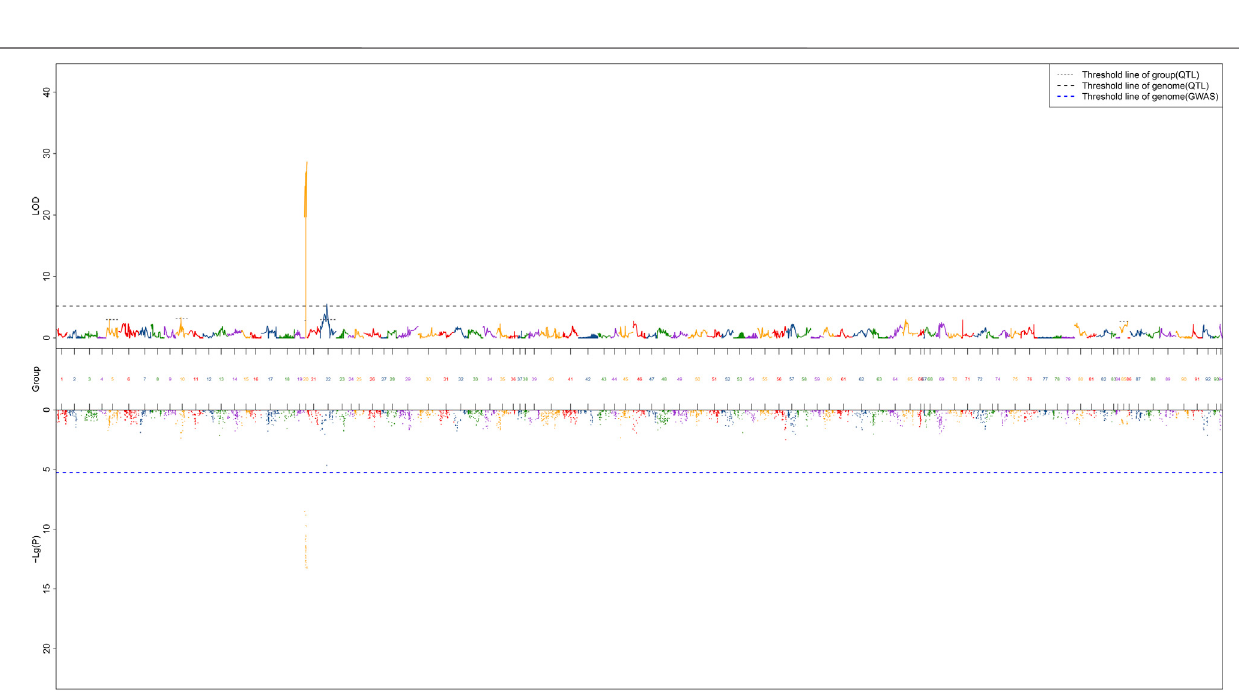
Frontiers in Genetics |